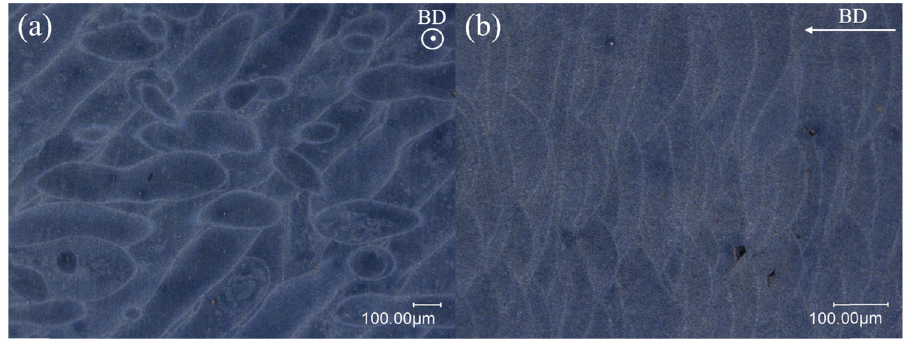
Figure 1: Microscopy of CNTs/AlSi10Mg nanocomposites ( the highly dense sample no. 3 with a relative density of 99.3% ) showing melt pool morphology: ( a ) dark fi eld microscopy of the top surface and ( b ) the cross - section showing melt layers along the build direction with no apparent micropores or defects.